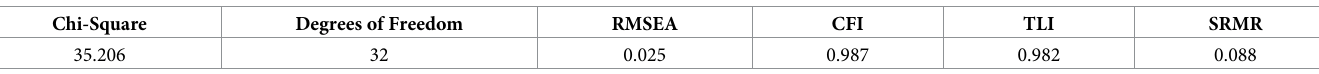
Table 3. Measurement